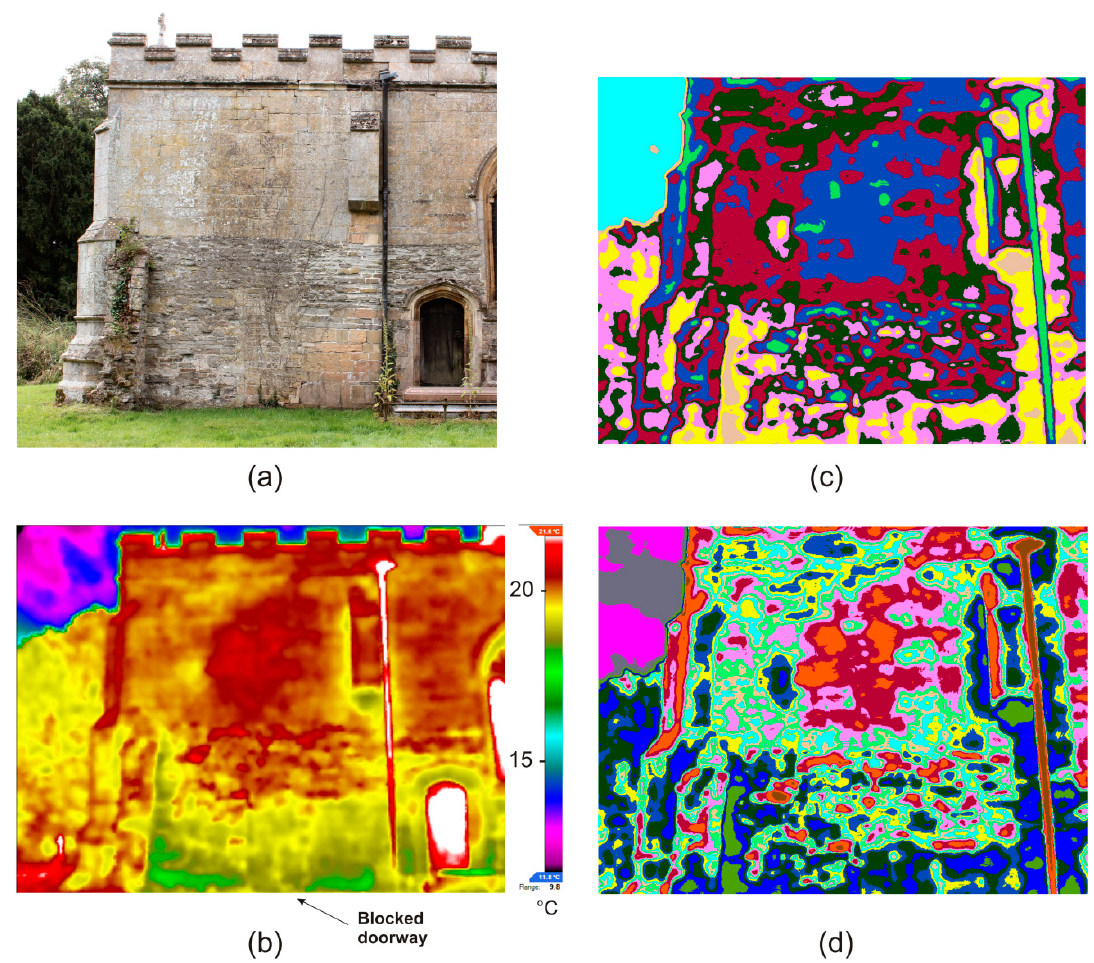
Figure 8. Kelham church, Nottinghamshire, U.K., the exterior north wall of the chancel ( a ) under normal diffuse daylight conditions, as seen by the unaided eye; ( b ) in the thermal infrared with high-contrast LUT applied; ( c ) k -means clustering of the thermal image with eight clusters, and ( d ) k -means clustering of the thermal image with 16 clusters.